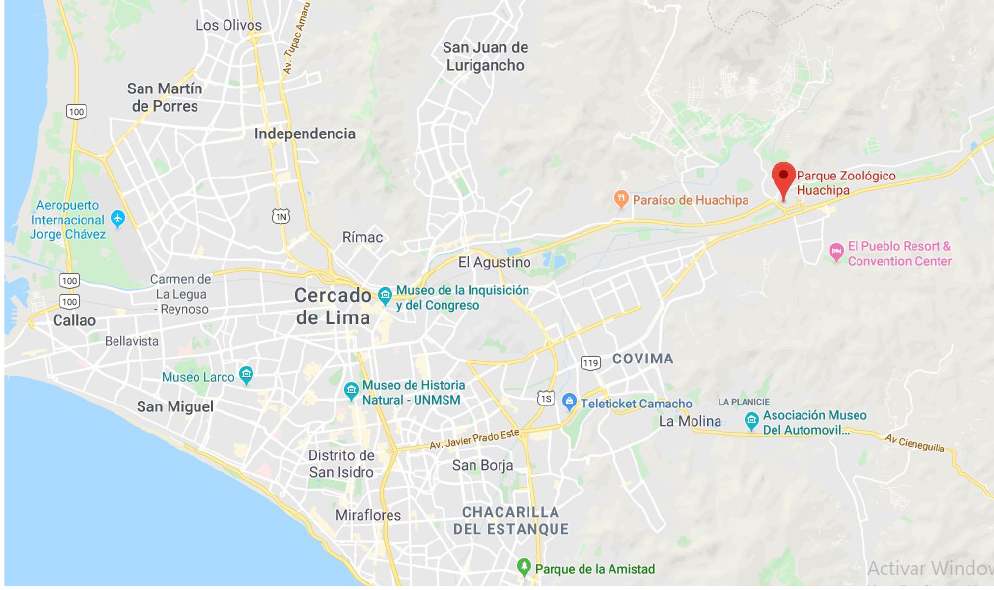
Figure 1 . Map of the project